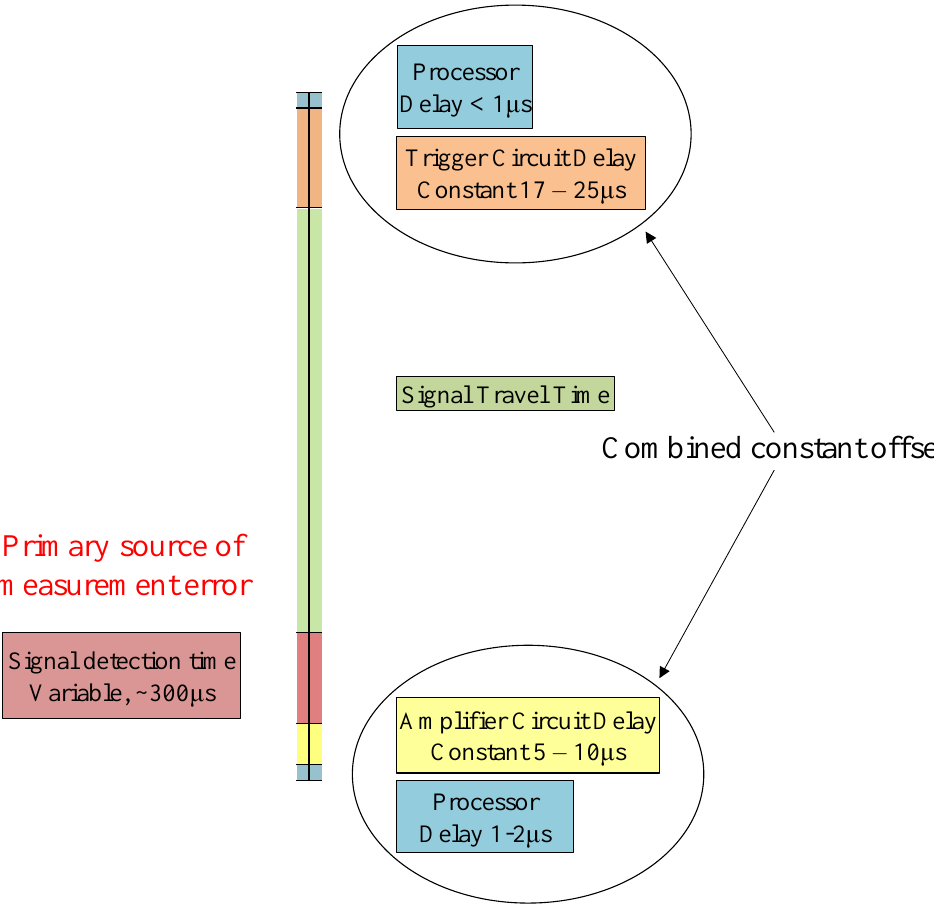
Figure 3. Signal timeline and sources of error (not to scale) [22]. Table 4. Values of ranging variables